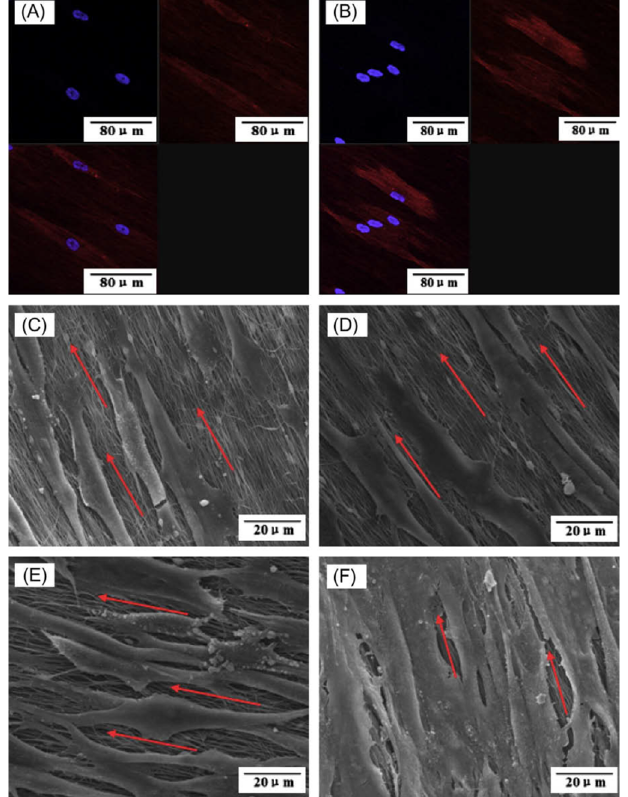
Figure 8. Morphology of PDLCs on the fabricated nanofibers. ( A ) CLSM image of cells on pristine CNFs, ( B ) CLSM image of cells on β -TCP-decorated CNFs, ( C ) SEM image of cells on pristine CNFs after 1 day of cell seeding, ( D ) SEM image of cells on pristine β -TCP-decorated CNFs after 1 day of cell seeding, ( E ) SEM image of cells on pristine CNFs after 7 days of cell seeding, and ( F ) SEM image of cells on pristine β -TCP-decorated CNFs after 7 days of cell seeding. Reproduced with permission from Ref [112].